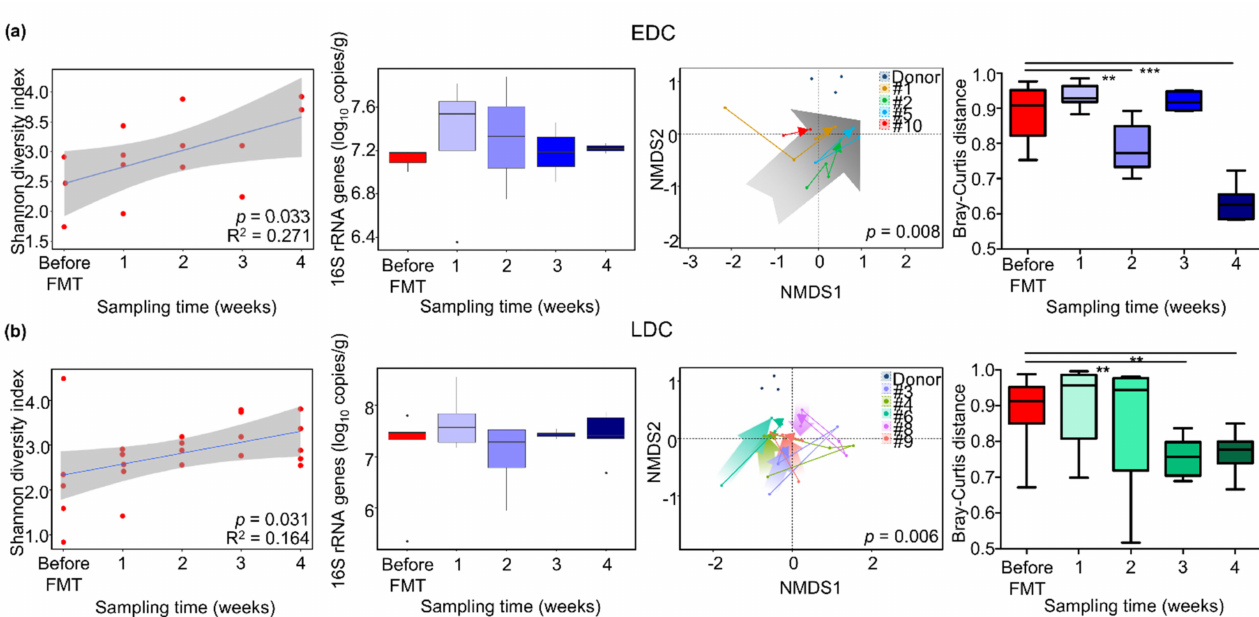
Figure 2. The alterations of gut microbiota were compared between ( a ) the early decolonization carriers (EDC) and ( b ) late decolonization carriers (LDC) in terms of sampling times. The changes in diversity were compared using the Shannon diversity index in terms of times. Bacterial 16S rRNA gene copies were estimated by quantitative real-time PCR. The convergence of gut microbiota in carriers to donor microbiota was analyzed using NMDS plots. The differences in gut microbiota via times were determined by the Bray–Curtis dissimilarity. *** p < 0.001, ** p < 0.01. NMDS, non-metric multidimensional